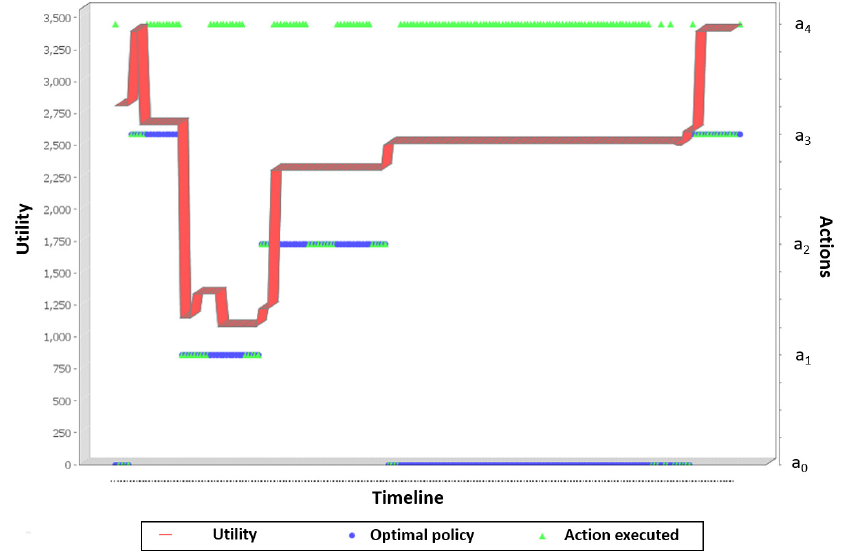
Figure 13. Utility plot for a plant running at medium load (20 MW). When the operator operator executes the recommended actions a 1 , a 2 or a 3 the utility increases. When the operator does not follow the recommended action a 0 and instead applies a 4 , the utility remains the same. In other cases, when the operator does not follow the recommended action, the utility